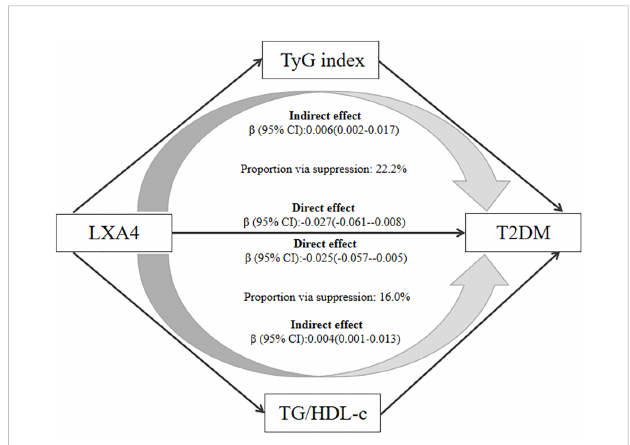
FIGURE 2 The mediating role of TyG and TG/HDL-c in the association between LXA4 and T2DM. All mediators were standardized using Z-scores to facilitate comparison. Adjusted for baseline age and